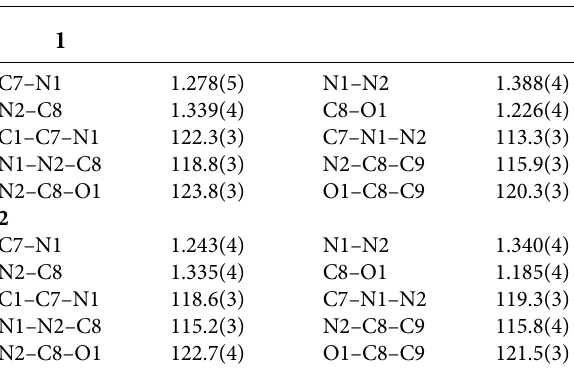
Table 2. Selected bond lengths (Å) and bond angles (°) for the com- pounds 1 and